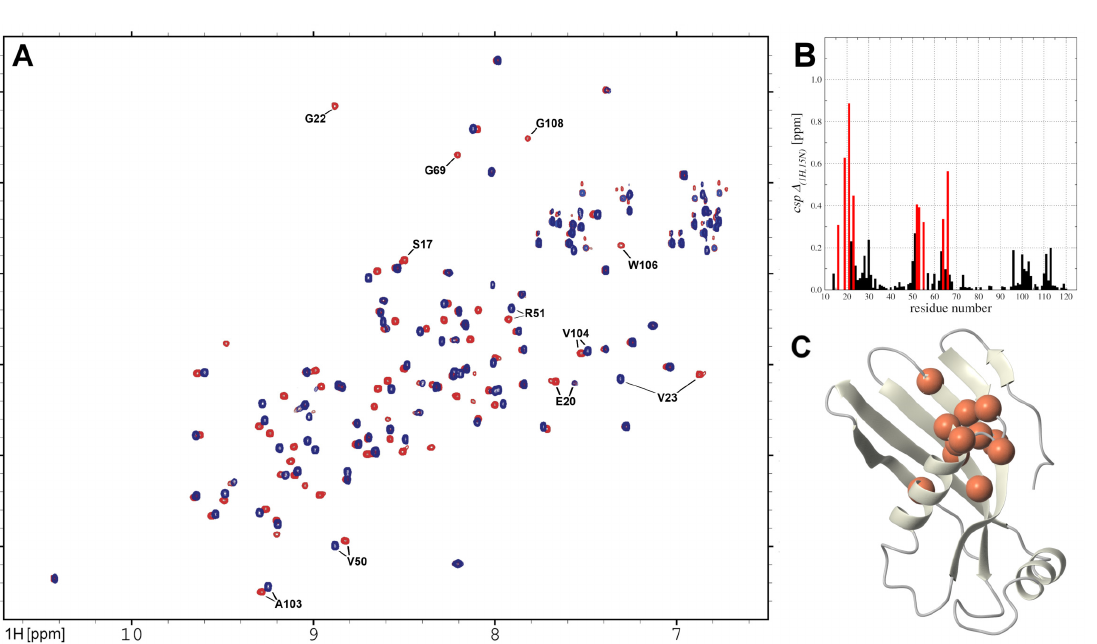
Figure 6. ( A ) The overlay of 1 H- 15 N HSQC spectra acquired for h CC V57G variant in solution without (blue) and with DMPC- d 54 (red); ( B ) The csp plot for 1 H and 15 N chemical shifts in sequence-specific manner, with amino acid residues taking part in interaction with DMPC- d 54 ( csp > 0.2) marked red; ( C ) Model of h CC V57G protein; amino acids exhibiting csp > 0.2 marked as red